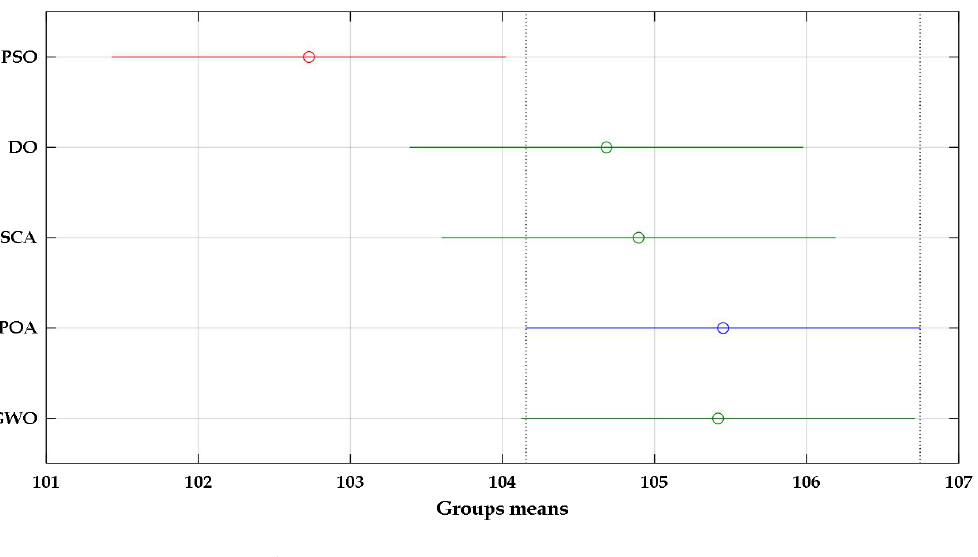
Figure 9. Tukey test.